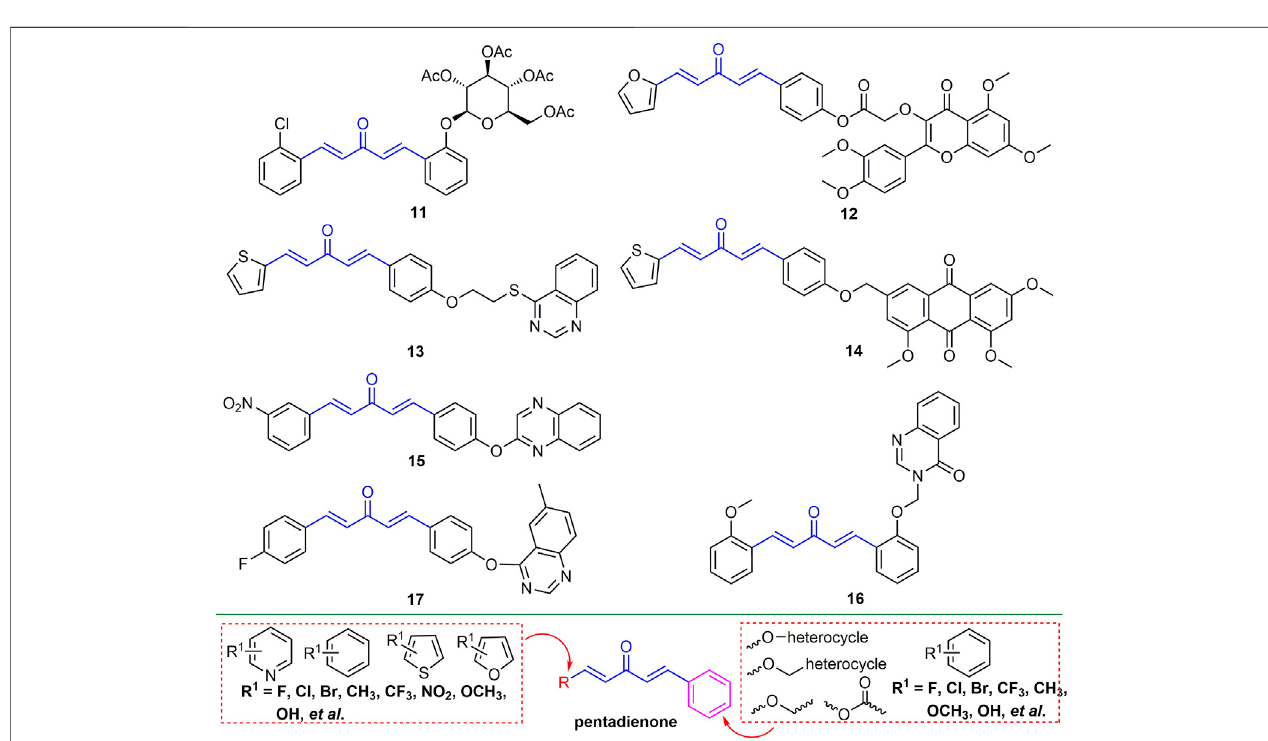
FIGURE 5 | Structures of representative pentadienone derivatives in antiviral